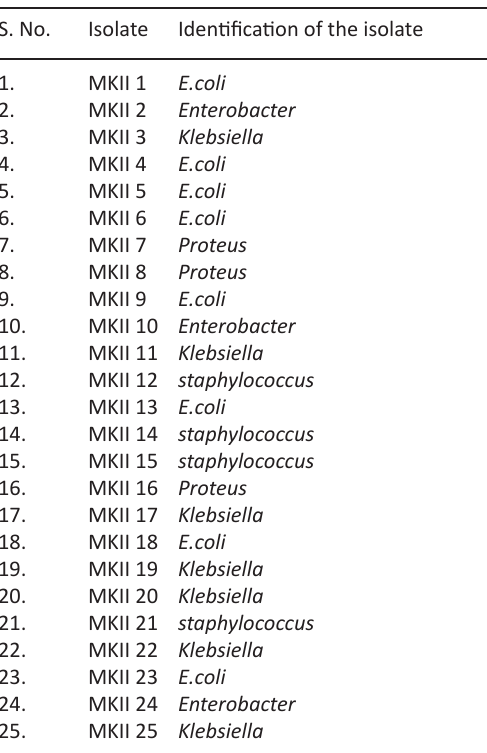
Table 7. Biochemical identification of bacteria Table 8. Antibiogram pattern of bacterial isolates